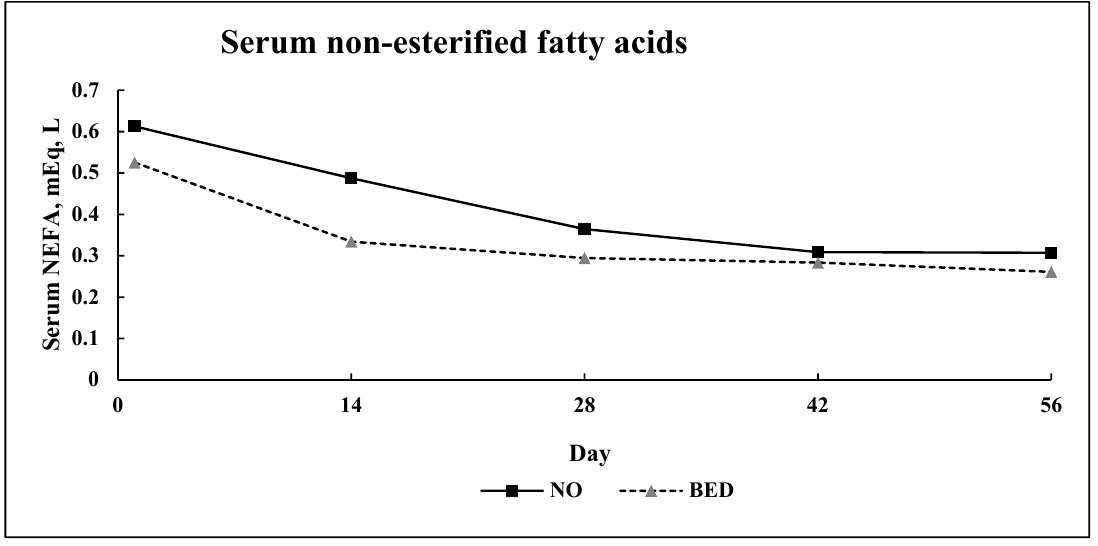
Figure 5. Experiment 2: Effect of bedding treatment on serum concentration of urea-N (SUN) in finishing steers ( n = 9 pens / treatment; pooled bed × day SEM (Standard error of the mean) = 0.82). Treatments were: (1) no bedding (NO) or (2) 1.0 kg (as-is basis) of wheat straw bedding/steer·d − 1 (BED). Blood was collected and harvested as sera on days 1, 14, 28, 42, and 56.